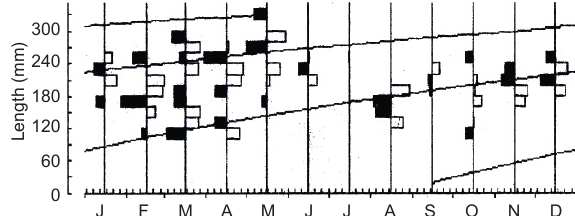
Figure 4. Growth curve of pooled population of Horabagrus brachysoma from River Periyar by ELEFAN 1 superimposed on the restructured length frequency diagram (L = 422mm, K = 0.55 yr -1 and Rn = 0.255) α